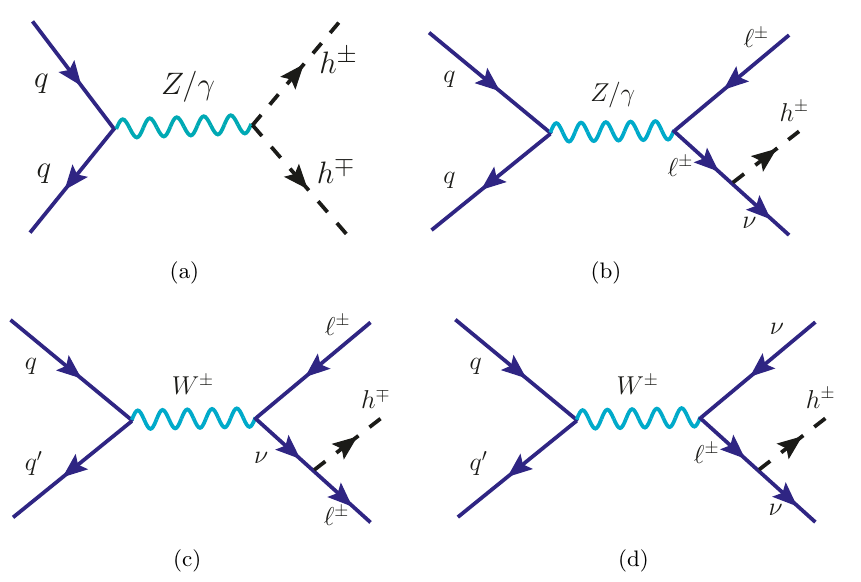
Figure 12 . Feynman diagrams for pair- and single-production of singly-charged scalars h (cid:6) at LHC. a bound on the charged scalar mass, as shown in (cid:12)gure 11 by the purple-shaded regions. It is evident that the LHC limits can be evaded by going to larger BR